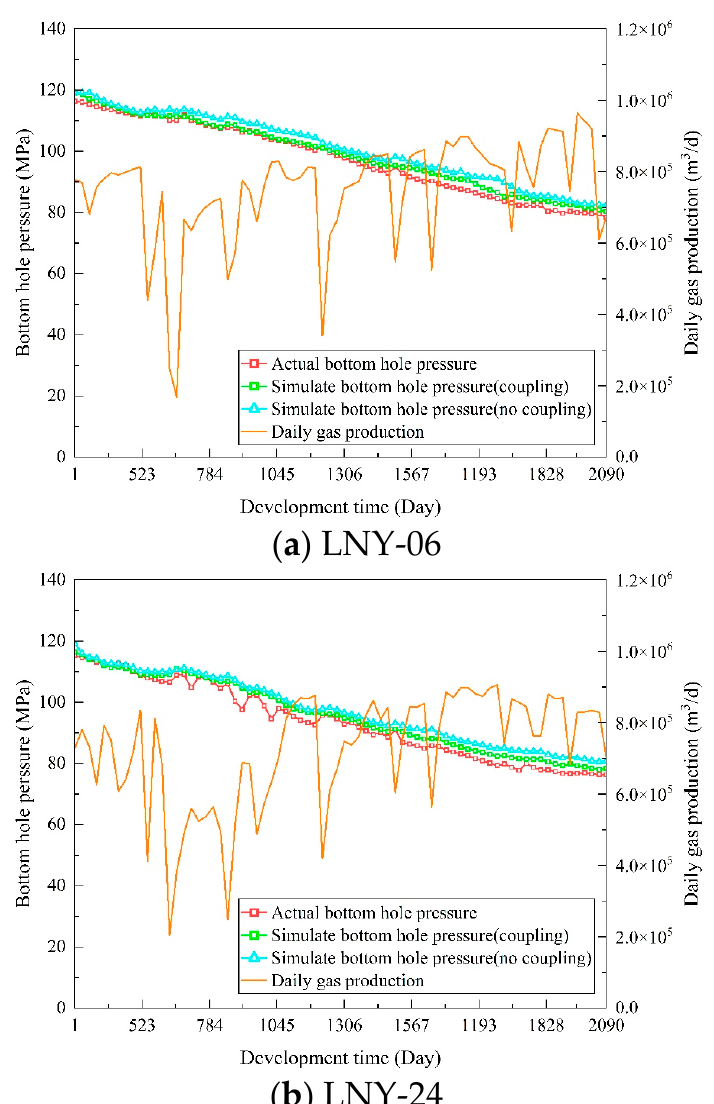
Figure 19. Production history matching.